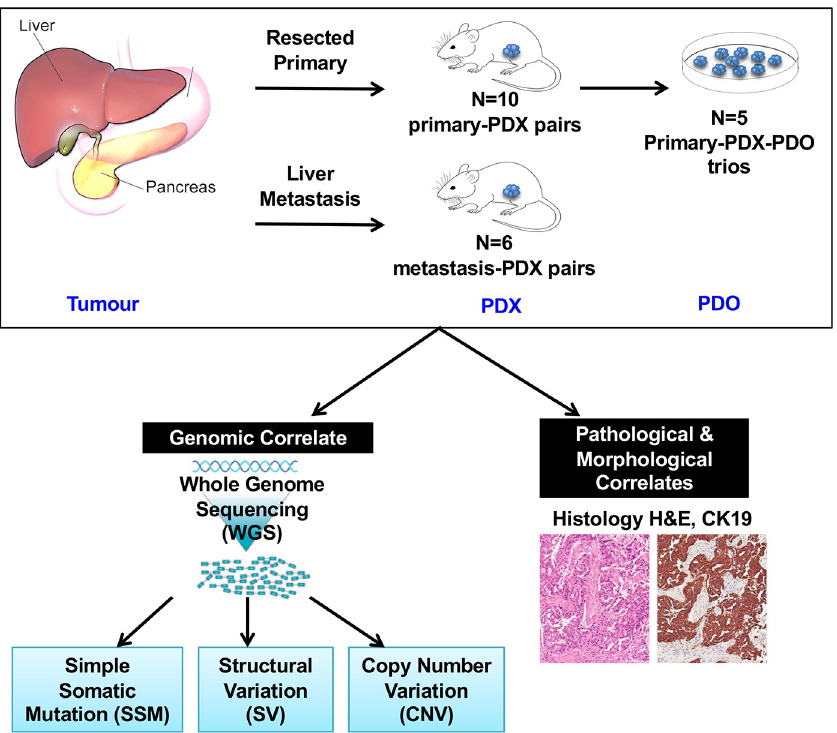
Fig 1. Schematic overview of samples and analysis. Disease models (PDX and PDO) were compared against matched human tumours in terms of morphological agreement, and genomic agreement. Assessment of genomic agreement was established by a top-down approach that determined genomic changes at varying levels of complexity, spanning single-based resolution (SSM) towards genome-wide comparisons (CNV).